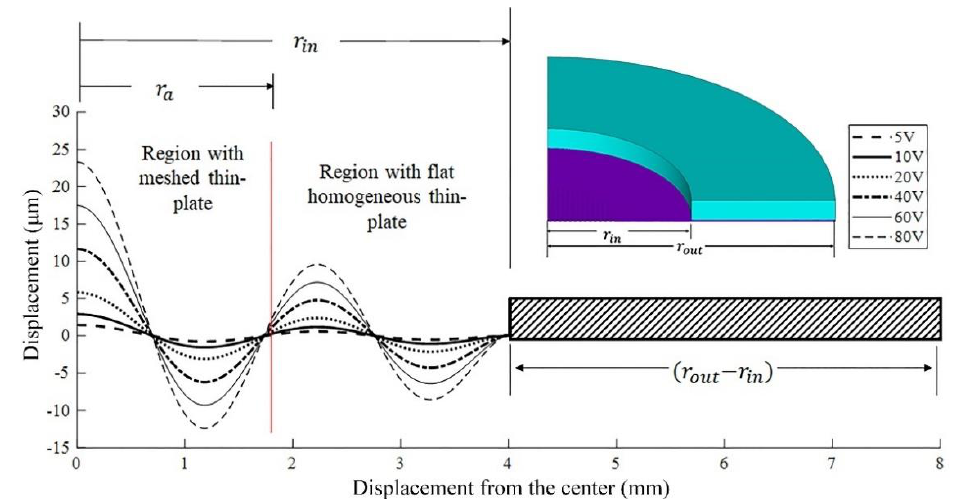
Figure 9. Distribution of the displacements along the cross-section of the thin plate for the 110 kHz (axisymmetric mode) resonance frequency as a function of the voltage.